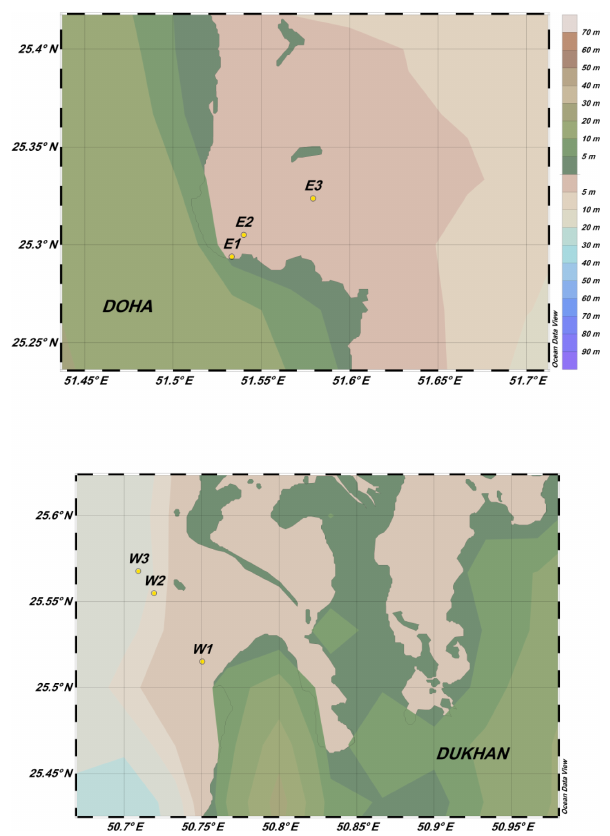
Figure 2. Station locations for the detailed nearshore sampling in April 2014 near Dukhan Bay and Doha Bay. The Ocean Data View (ODV) program was used for plotting the figures (Schlitzer,